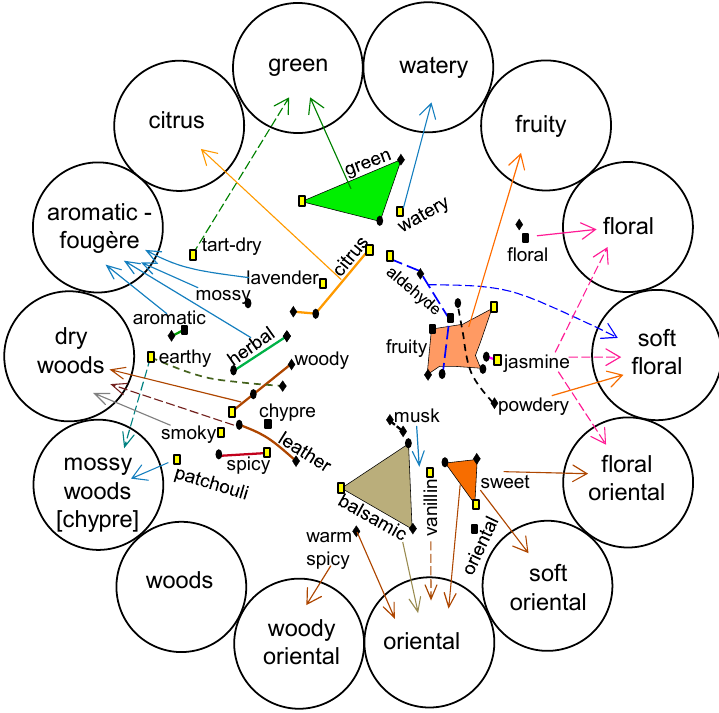
Figure 6. The Fragrance Wheel (perfume categories displayed within circles). The sequence around the central hub is the same as that proposed by Edwards [11] (except for “green” and “watery”, which were swapped). The Wheel was properly rotated to achieve the maximum correspondence with related studies [26,30] as well as with Figure 2, which is also depicted inside (some descriptors were removed for clarity purposes). Arrows indicate the most typical notes of each olfactory class.